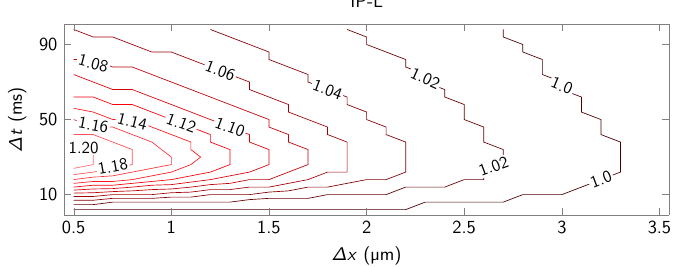
Figure A1. Oxygen diffusion model fitted to the experimental data. The calculation is done on a discretized grid and no smoothing is